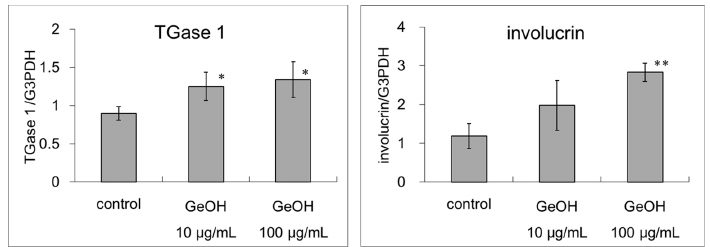
Figure 2. Effects of GeOH on TGase1 and involucrin mRNA expression levels in cultured epidermal keratinocytes. HaCaT cells were cultured for 3 days in medium supplemented with 10 or 100 μ g/mL GeOH. Total RNA was isolated from the cells, and quantitative reverse transcription-polymerase chain reaction was performed using three samples. The results are shown relative to the control. * p < 0.05 vs. control, ** p < 0.01 vs. control.